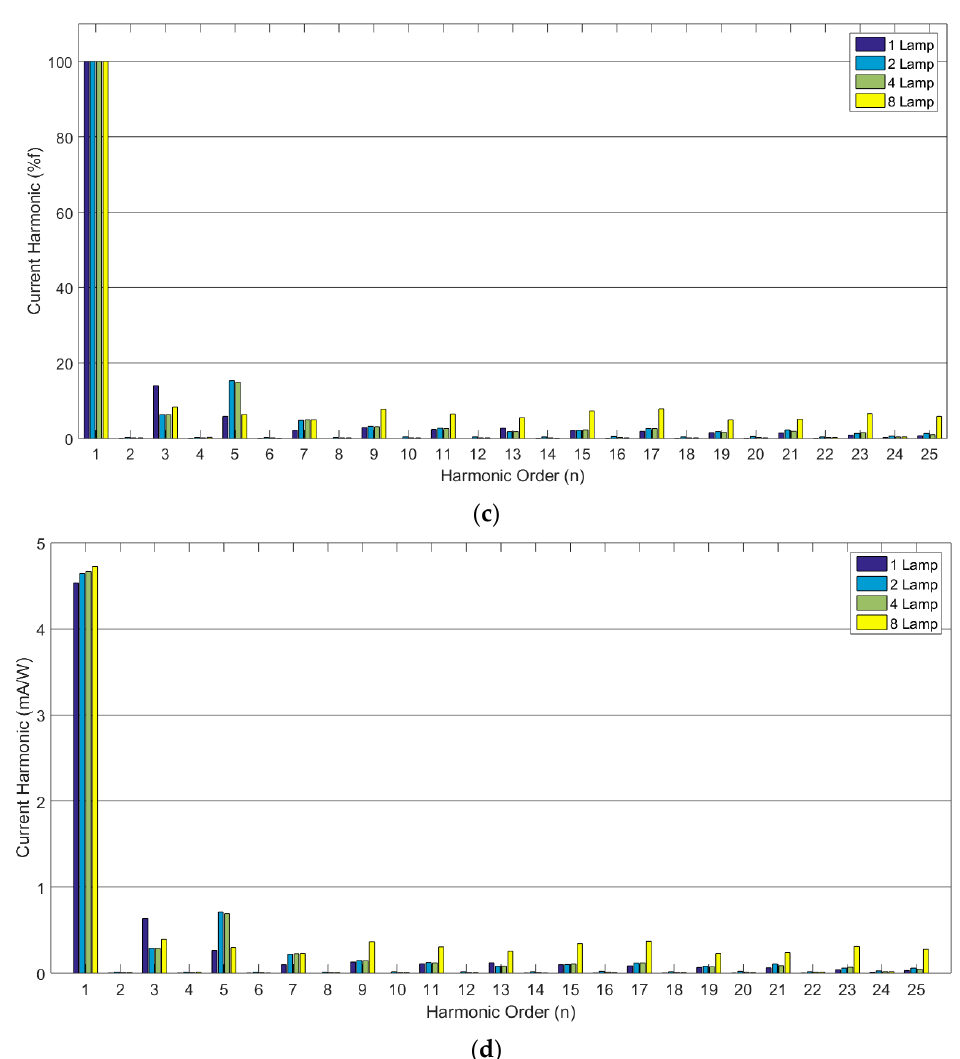
Figure 12. Harmonic spectrum among cases of each LED lamp with internal driver. ( a ) Harmonic spectrum of Brand C LED lamp (%f); ( b ) Harmonic spectrum of Brand C LED lamp (mA/W); ( c ) Harmonic spectrum of Brand D LED lamp (%f); ( d ) Harmonic spectrum of Brand D LED lamp (mA/W).